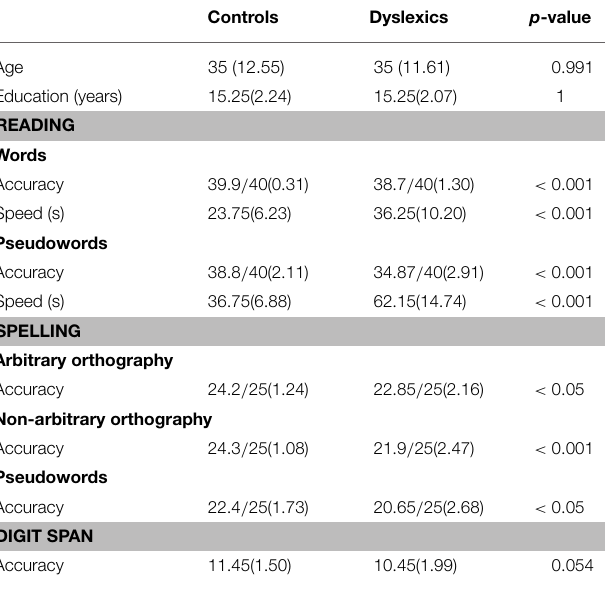
TABLE 1 | Means and standard deviations for demographic characteristics, reading and spelling scores of control and dyslexic